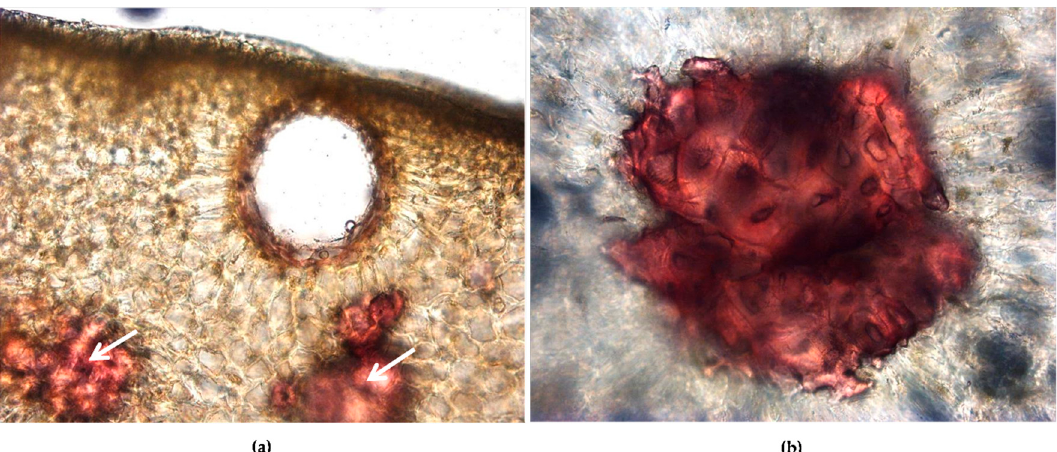
Figure 2. Light microscopy (LM) micrographs ( a , b ). Transversal sections of the fruit peel showing a schizogenous secretory cavity, located near the epidermis, ( a ) and many stone cells stained in red ( a , white arrows and b , at higher